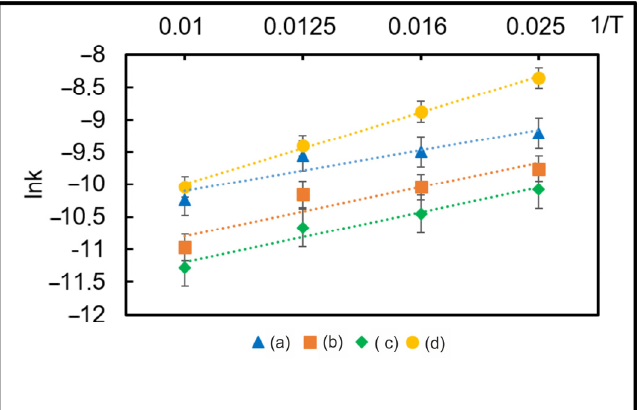
Figure 4. Arrhenius plot for the humic acid leaching of PS and CD: (a) PS-CD/HA ratio = 1/1, pH = 1.92; (b) PS-CD/HA ratio = 1/2, pH = 1.92; (c) PS-CD/HA ratio = 1/1, pH = 1.5; (d) PS-CD/HA ratio = 1/2, pH = 1.5.